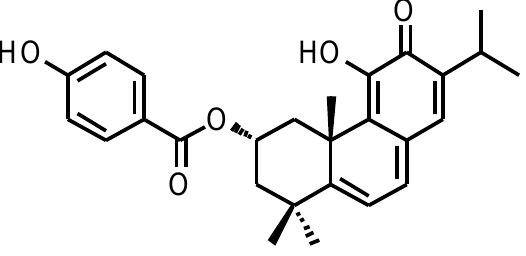
Figure 1. Chemical structure of Parvifloron Figure 1. ( a ) Chemical structure of Parvifloron D.